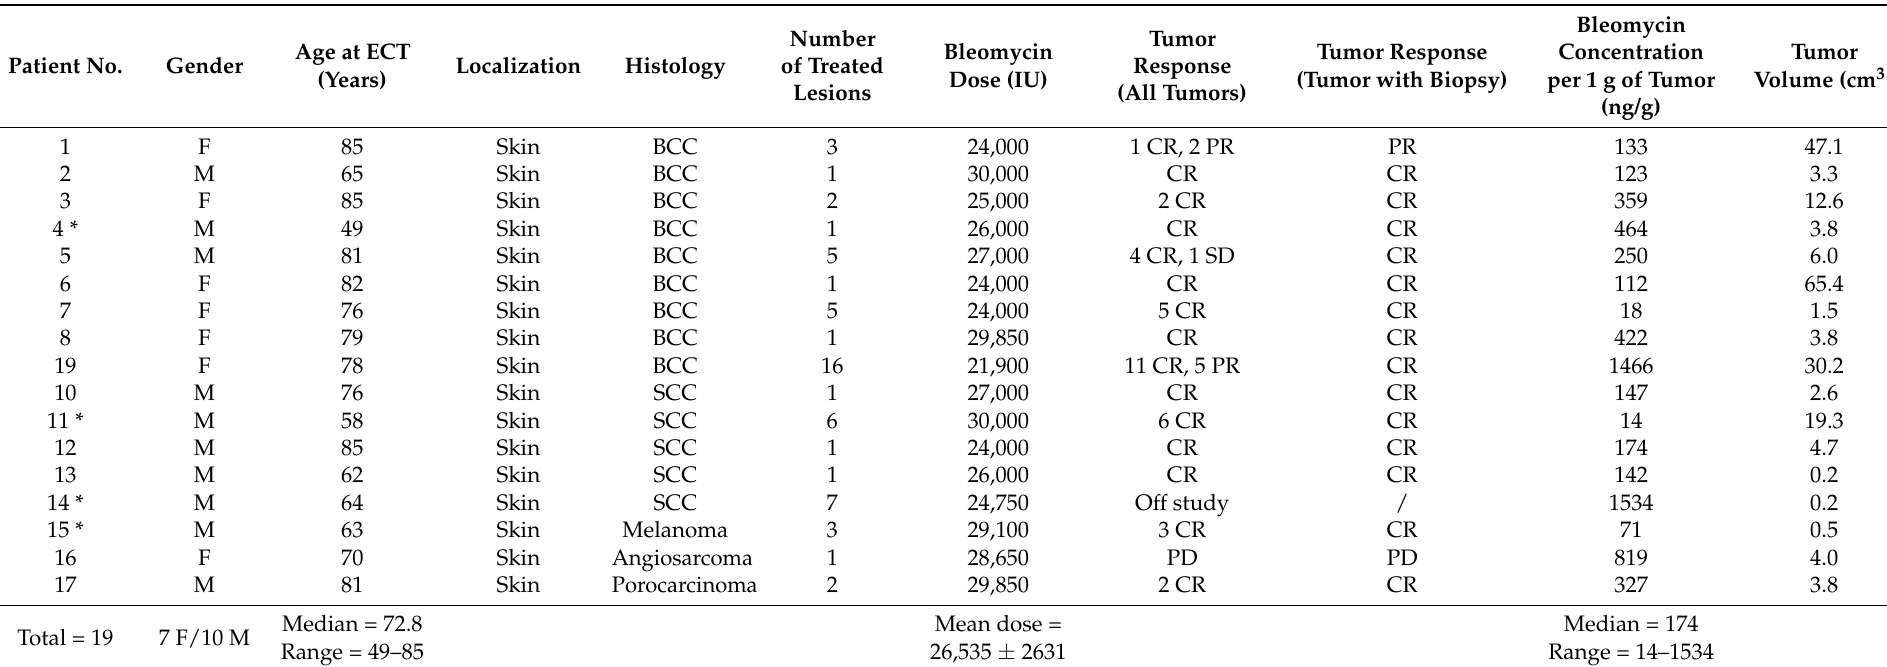
Table 3. Characteristics of patients eligible for one tumor sample collection, according to the tumor histotype, age of patients, bleomycin dose given in treatment with electrochemotherapy and tumor response after 2 months according to RECIST 1.1 criteria.